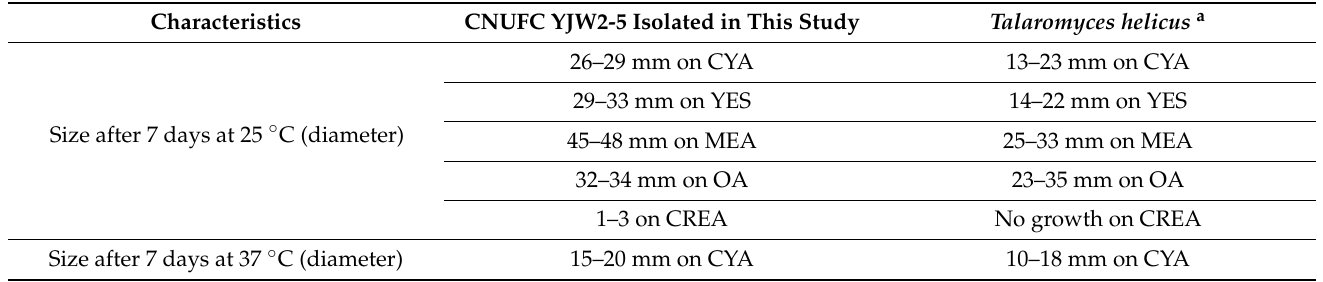
Figure 6. Morphology of Talaromyces teleomorpha CNUFC YJW2-5. ( A , E ) Colonies on Czapek yeast autolysate agar (CYA). ( B , F ) Malt extract agar (MEA). ( C ) Yeast extract sucrose agar (YES). ( D ) Oatmeal agar (OA). ( G ) Dichloran 18% glycerol agar (DG18). ( H ) Creatine sucrose agar (CREA). (( A – D , G , H ) Obverse view and ( E , F ) reverse view). ( I , J ) Ascomata. ( K – P ) Asci and ascospores. (( I , J ) Stereomicroscope, ( K – M ) LM and ( N – P ) SEM). Scale bars: ( I , J ) = 1 mm, ( K – M ) = 10 µ m, and ( N – P ) = 5 µ m. Table 4. Morphological characteristics of Talaromyces teleomorpha CNUFC YJW2-5 compared with those of the reference strain Talaromyces helicus